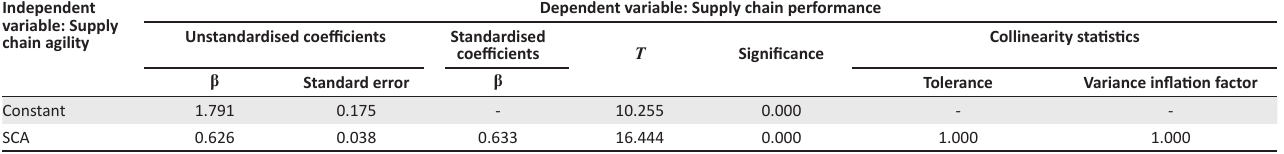
TABLE 5 : Regression model 2: Supply chain agility and supply chain performance. Independent variable: Supply chain